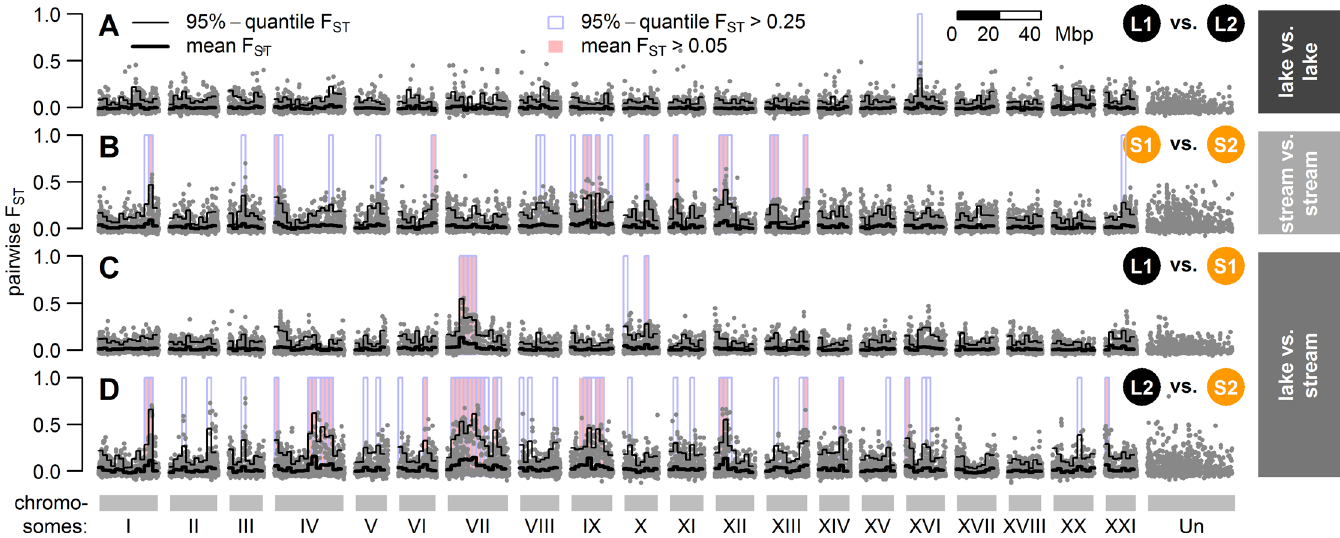
Fig 3. Distribution of pairwise differentiation (F ST ) across the genome. Panels A and B show comparisons between sites with similar habitat (A) lake- lake (parapatric), (B) stream-stream (allopatric). Panels (C) and (D) show the two replicate lake-stream comparisons L1/S1 (sympatric breeding) and L2/S2 (parapatric breeding; see S4 Fig for other pairwise comparisons). Grey dots show single SNP pairwise F ST estimates and black lines show F ST means (bold) and 95%-quantiles (thin) in 2 Mb wide, non-overlapping windows across the genome. Windows with elevated differentiation are highlighted with blue background frames (mean F ST > 0.05) and red background bars (95%-quantile F ST > 0.25).